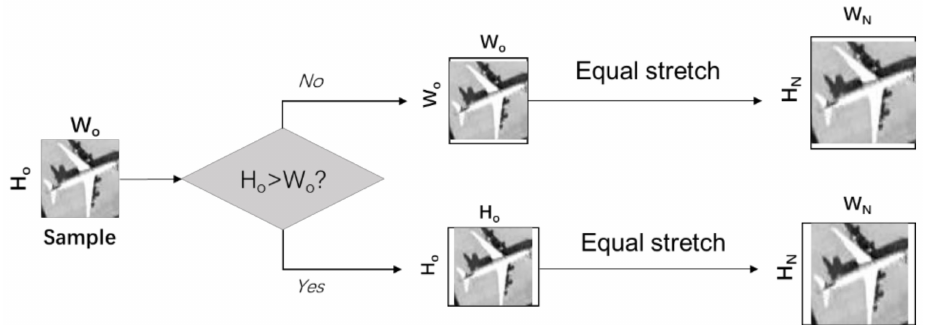
Figure 5. The flow diagram of the equal stretch resize.